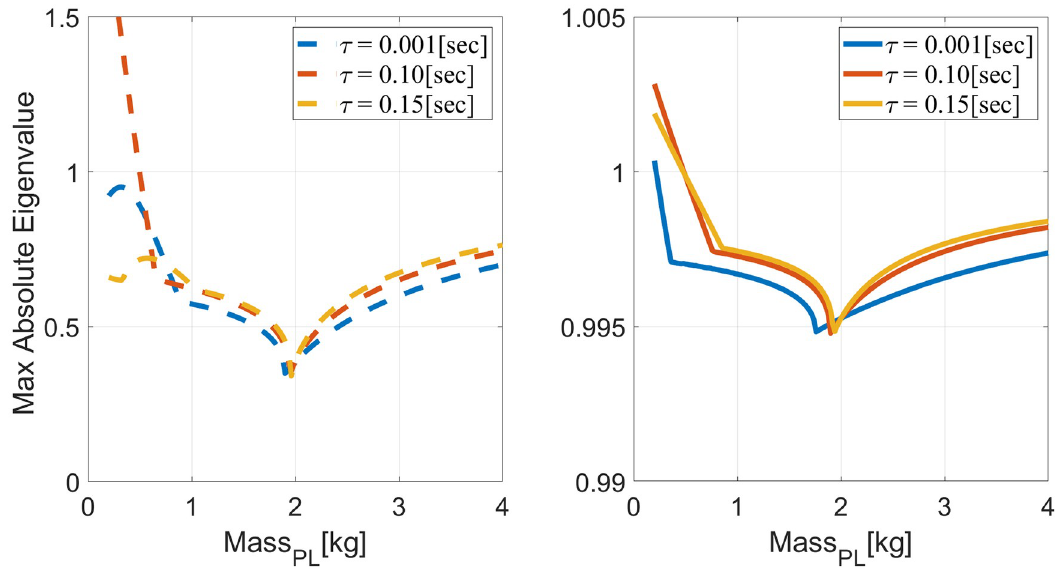
Fig 4. Eigenvalue analysis of reaching movements with LTI plant, observer and controller, for m IM = 2[Kg] as a function of m PL 2 [0.2, 4][Kg]. Left panel: periodic IC with h = 0.2[sec]. Right panel: discrete equivalent system of CC with Δ = 10 − 3 . In both cases stability is lost when the maximal absolute eigenvalue is larger than one.